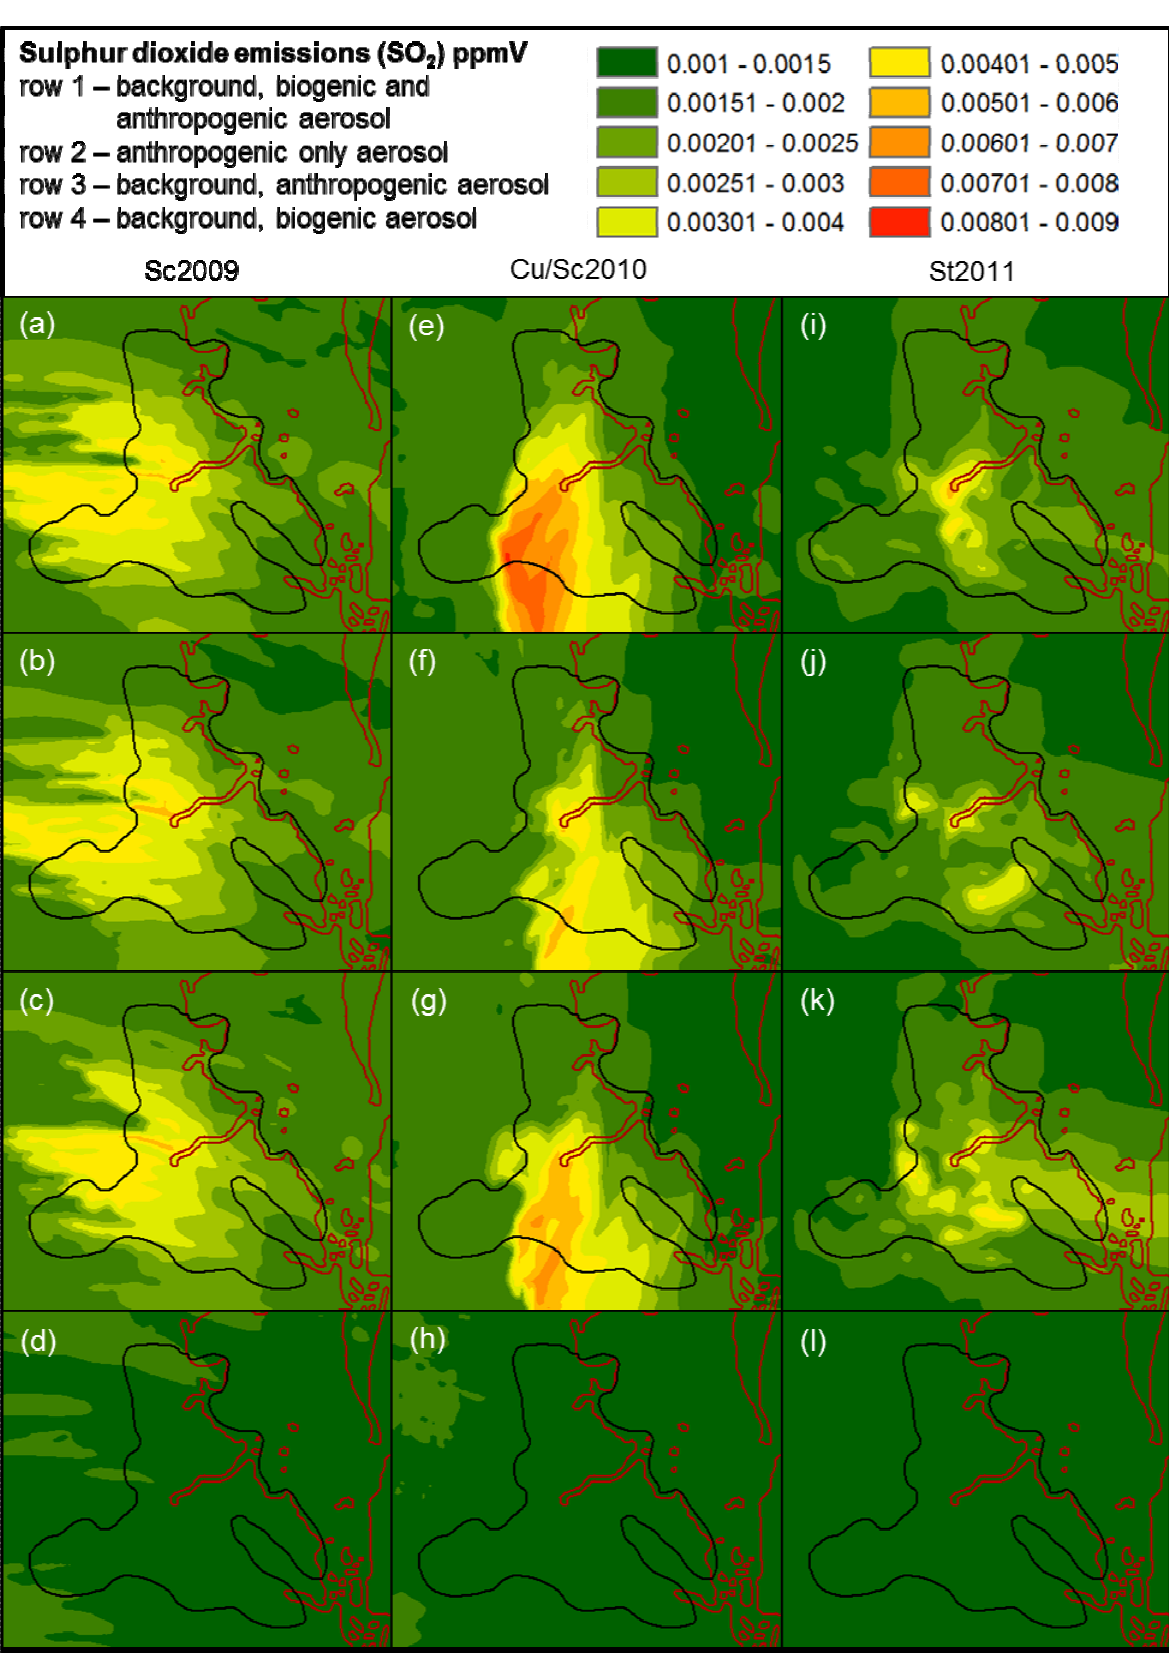
Figure 7. WRF sulphur dioxide (SO ) emissions for four aerosol transport scheme 2 configurations and three rain events: ( a – d ) Sc2009; ( e – h ) Cu/Sc2010 and ( i – l )